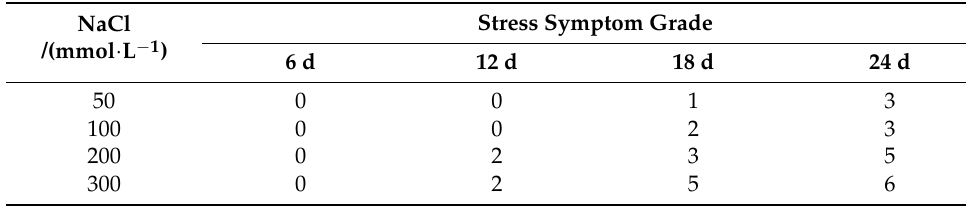
Table 2. Leaf salt injury classification of J. microcarpa L.